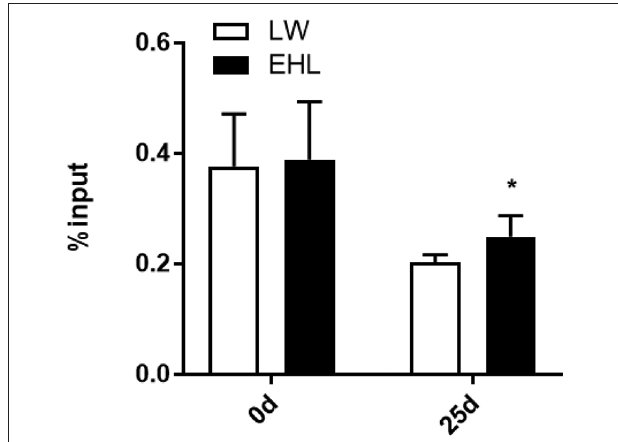
FIGURE 4 | DNA methylation at HMGCR promoter in the liver of weaning piglets ( n = 6 piglets each time point per breed). * P < 0.05. Data are presented as mean ±